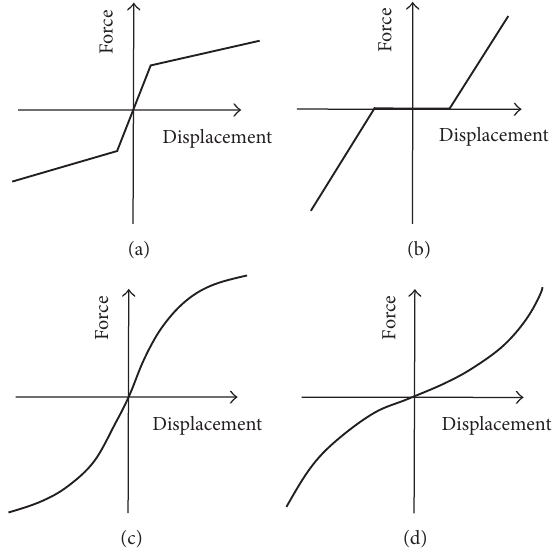
Figure 1: Force-displacement relation of nonlinear elastic restraints: (a) bilinear spring; (b) gap and spring in series; (c) softening system; (d) hardening system.